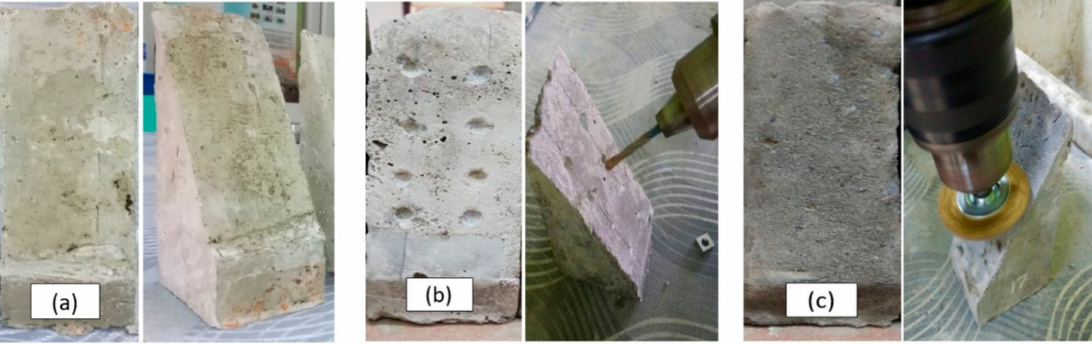
Figure 1. Various types of surface preparation on the OPCC substrate: ( a ) left as-cast; ( b ) drill holes; and ( c ) wire